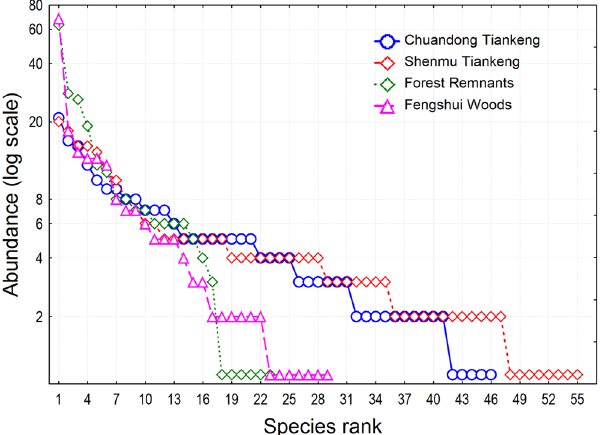
Figure 1. Rank abundance curves by species, showing number of species across habitats and the abundance and evenness patterns.